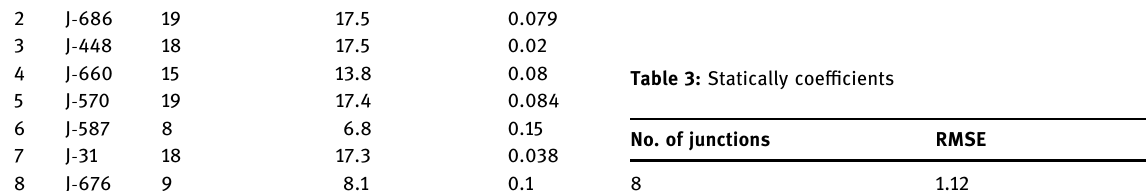
Table 3: Statically coe ffi